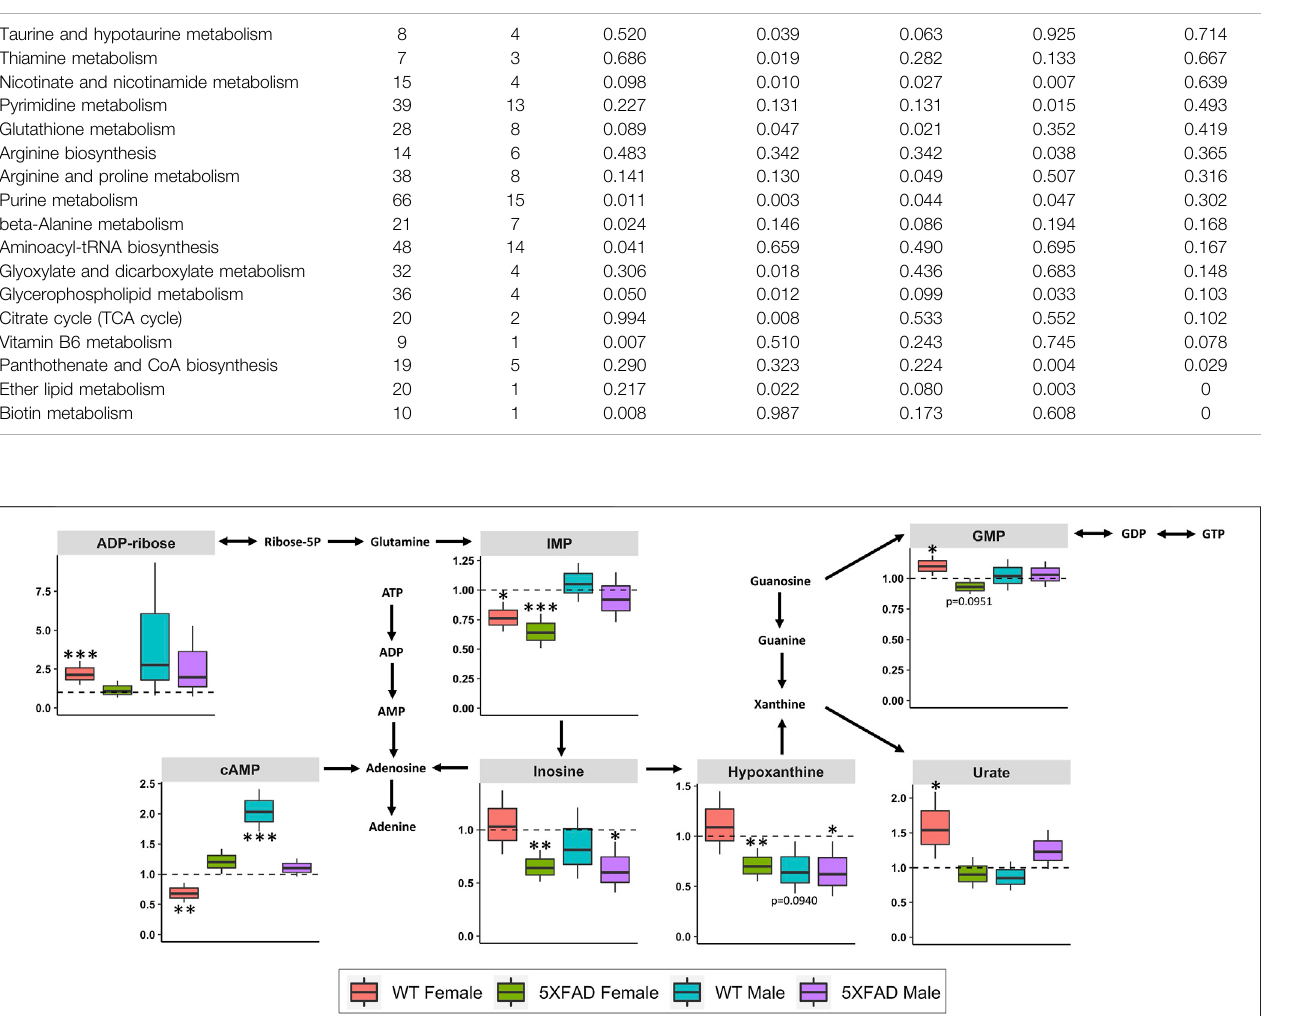
Frontiers in Pharmacology |